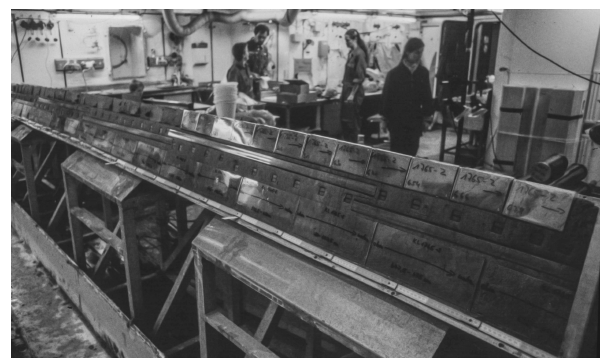
Figure 3. Sediment core taken with a kasten corer (30cm × 30cm) prepared with Plexiglas lids to remove the samples for X-raying.